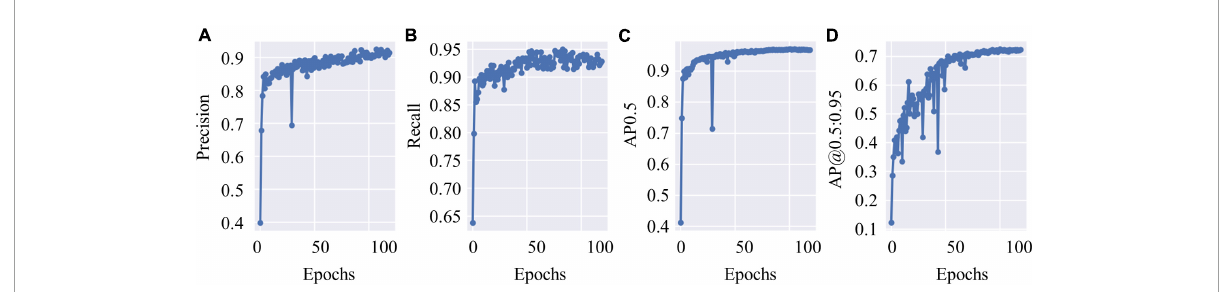
FIGURE4 The test results of you-only-look-once-v5 (YOLOv5). (A) The precision values of YOLOv5 during test with epochs. (B) The recall values of YOLOv5 during test with epochs. (C) Average precisions (AP) values with the intersection over union (IoU) threshold value as 0.5. (D) AP values with different IoU threshold values that range from 0.5 to 0.95 with 0.05 step size.